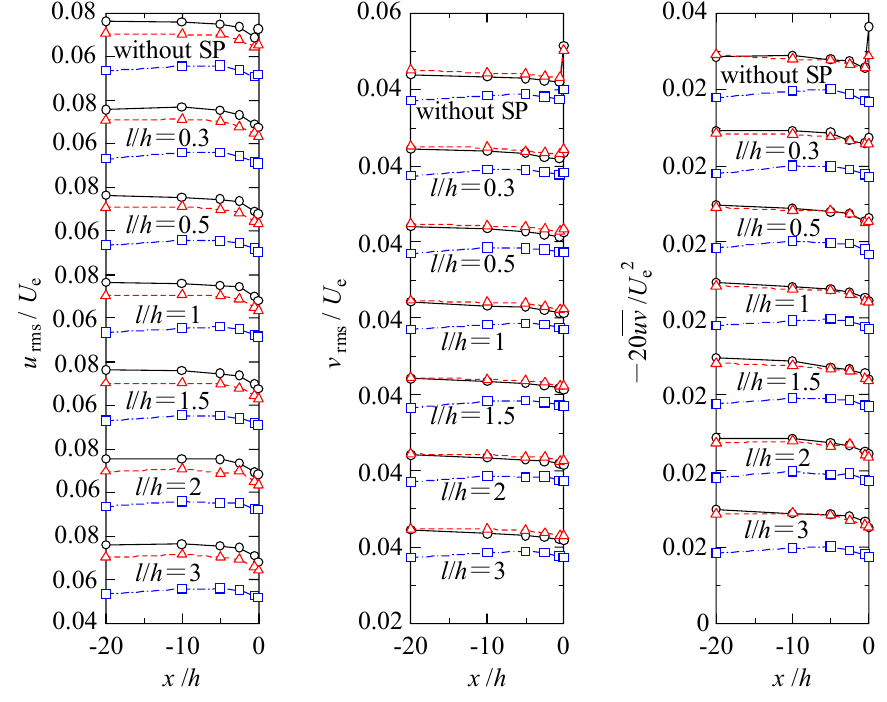
Fig. 5 Streamwise variation in turbulent quantities: ○ , y / h ≒ 0.14 ( y / δ≒ 0.1); △ , y / h ≒ 0.29 ( y / δ≒ 0.2); □ , y / h ≒ 0.74 ( y / δ≒